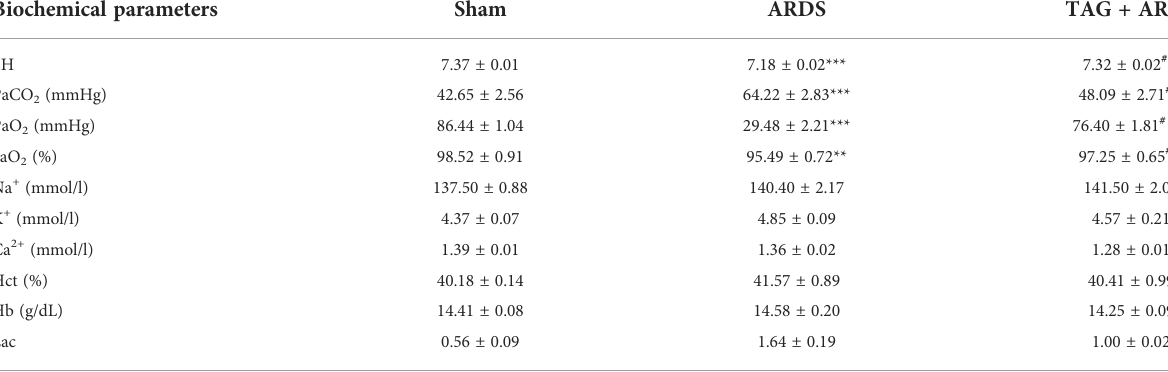
TABLE 2 Metabolic changes in each group throughout the procedure. Biochemical